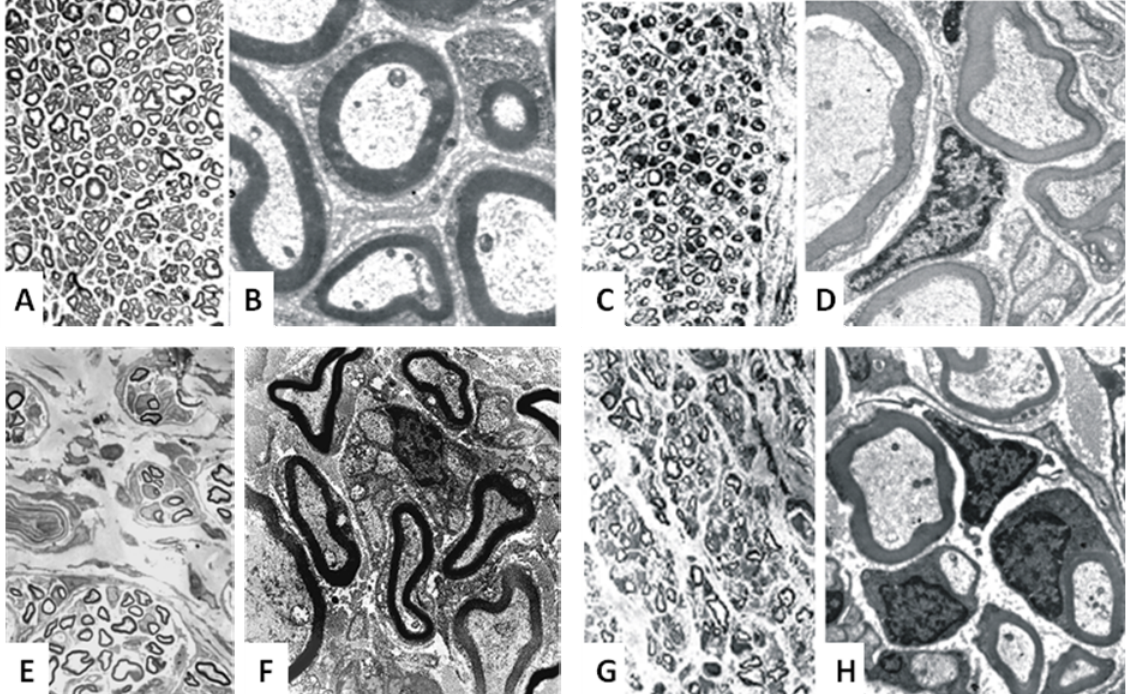
Figure 4. Histological evaluations of regeneration results of different nerve